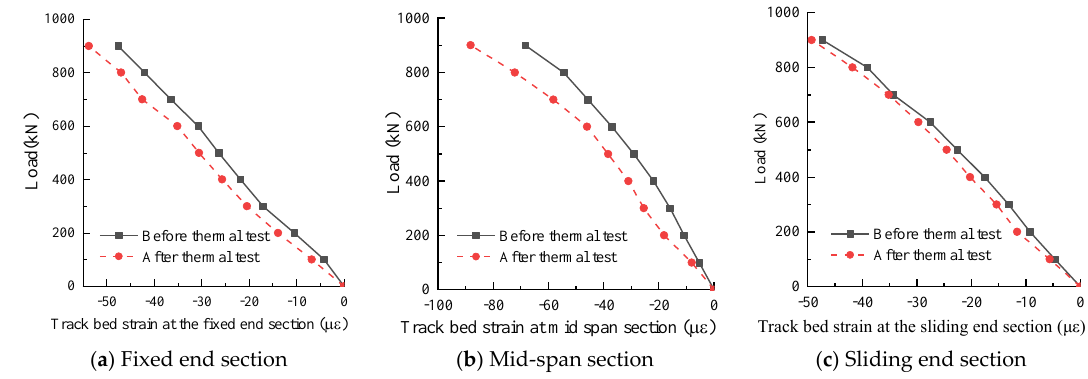
Figure 22. Load–strain curve of the track bed under static load.